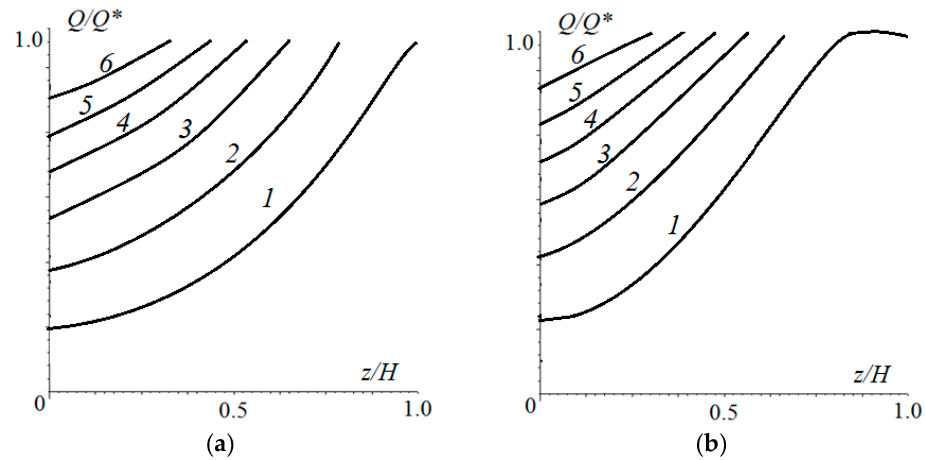
Figure 8. Distribution of damage within the elastic layer at different moments of time. Stochastic time load distribution varied from the average nominal pressure by ± 20% ( a ) and ± 80% ( b ) of average amplitude. N / N ∗ = 1, 1.1, 1.2, 1.3, 1.4, or 1.5 (( a ), curves 1-6, respectively), N / N ∗ = 1, 1.07, 1.14, 1.21, 1.28, or 1.35 (( b ), curves 1–6, respectively), ν = 0.4, p n (cid:48) = 4.2 · 10 − 2 , h (cid:48) = 0.667, V (cid:48) =